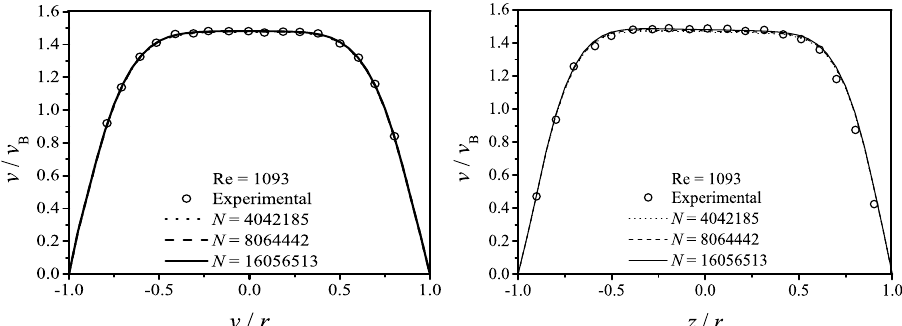
Figure 4. Comparison of the numerical normalized horizontal ( left ) and vertical ( right ) streamwise velocity profiles with the experimental measurements at S 2 = 0.58 D upstream of the bend inlet for Re = 500 and N = 4,042,185, 8,064,442 and 16,056,513 particles.